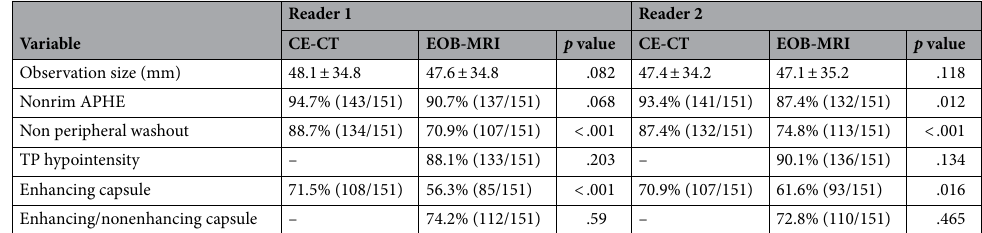
Table 3. Frequencies of LI-RADS Imaging Features of HCCs between in Contrast-Enhanced CT and Gadoxetic Acid-Enhanced MRI. Data are expressed as mean ± standard deviation for continuous variable and frequency (count) for categorical variables. The frequencies of TP hypointensity was compared with nonperipheral “washout”, and enhancing/nonenhancing “capsule” in EOB-MRI was compared with enhancing “capsule” in CE-CT. CE-CT contrast-enhanced CT, EOB-MRI gadoxetic acid-enhanced MRI, APHE arterial phase hyperenhancement, TP transitional